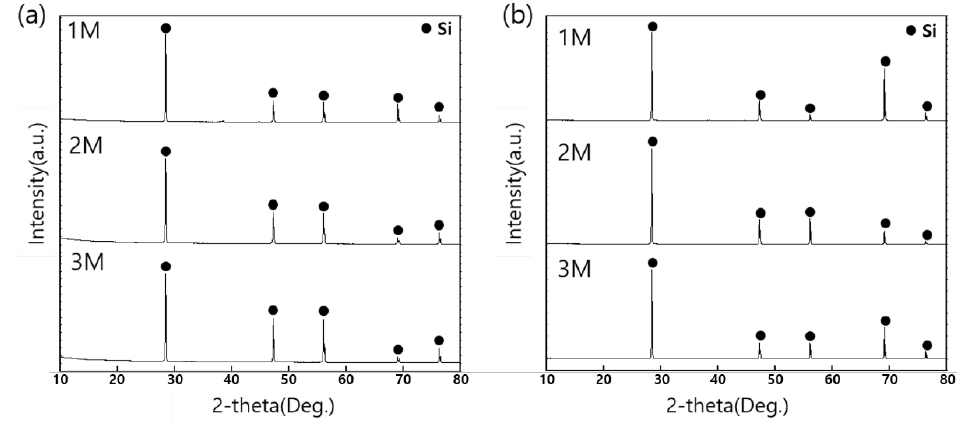
Figure 6. XRD analysis results of a photovoltaic cell after drying—concentration. ( a ) HNO 3 and HCl. ( b ) HCl. Table 1. XRF analysis results of a photovoltaic cell after drying—concentration (unit: wt.%).